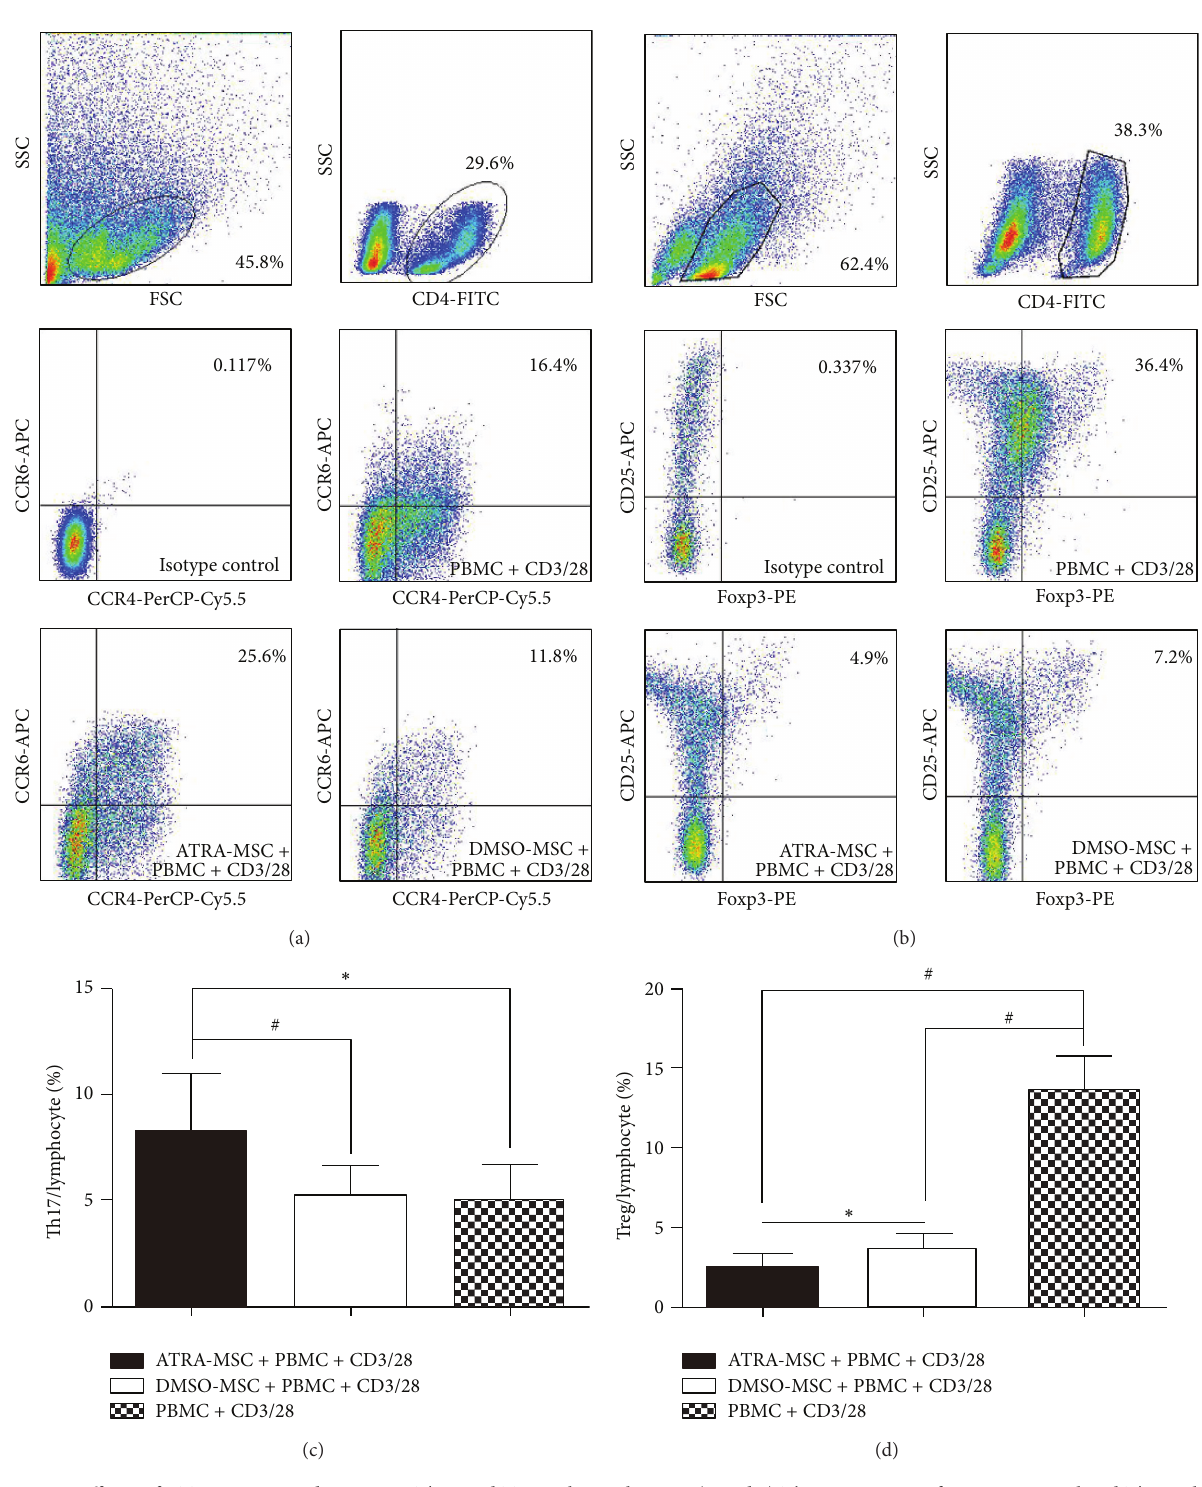
Figure 3: Effects of ATRA-pretreated MSCs on Th17 and Treg subpopulations. (a and c) The percentage of CD3/28-stimulated Th17 subset (Th17/lymphocyte). (b and d) The percentage of CD3/28-stimulated Treg subset (Treg/lymphocyte). One-way ANOVA was used. ∗ 𝑃 < 0.05 and # 𝑃 < 0.001